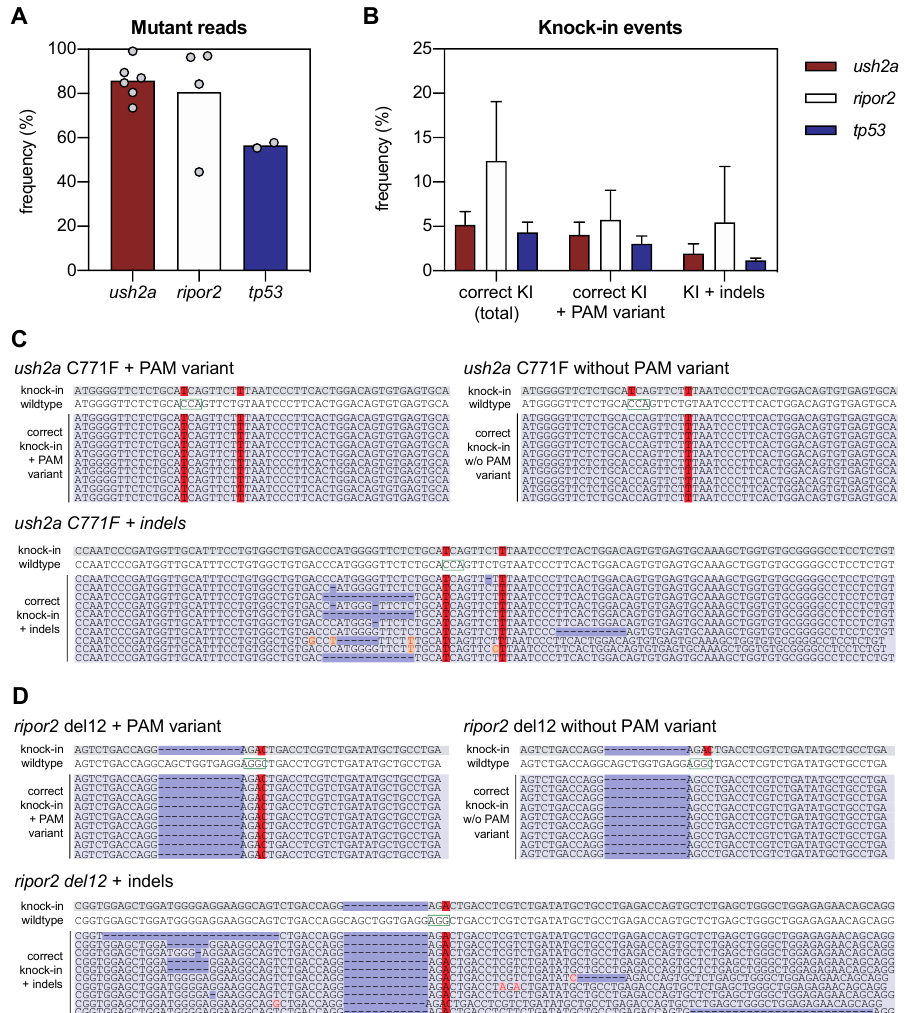
Figure 2. Next-generation sequencing analysis of knock-in efficiency after sgRNA-Cas9 RNP and HDR template delivery. ( A ) Percentage of mutant reads in the genomic DNA of pooled embryos after injection of sgRNA, Cas9, and asymmetric antisense oligonucleotide templates. Mutant reads are quantified as the percentage of all non-wildtype reads. Data is expressed as mean (bar) and values of individual replicates (scatterplot). ( B ) Knock-in efficiency after injection of sgRNA, Cas9 and asymmetric antisense oligonucleotide template. Knock-in (KI) reads are quantified as percentage of total reads with correct knock-in with and without the silent variant in the protospacer adjacent motif (PAM). The percentage of correct knock-in reads with additional variants is provided as KI + indels. Examples of correct knock-in reads with and without PAM variants and indels are provided for ( C ) ush2a C771F RNP injected embryos, and ( D ) ripor2 del12 RNP injected embryos. The correctly-introduced nucleotide substitutions are indicated in red. Unintended nucleotide substitutions are indicated with a red font on orange background. Deletions are indicated in dark blue. The PAM sites are indicated on the wildtype sequences by a green box.